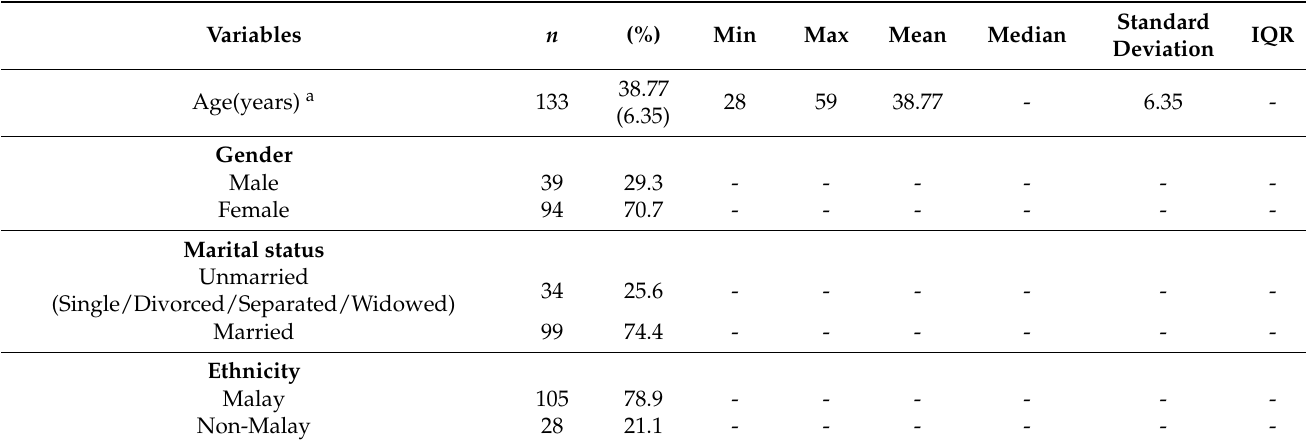
Table 1. Sociodemographic Characteristics of the Respondents and Summary of Descriptive Statistical Results ( n =